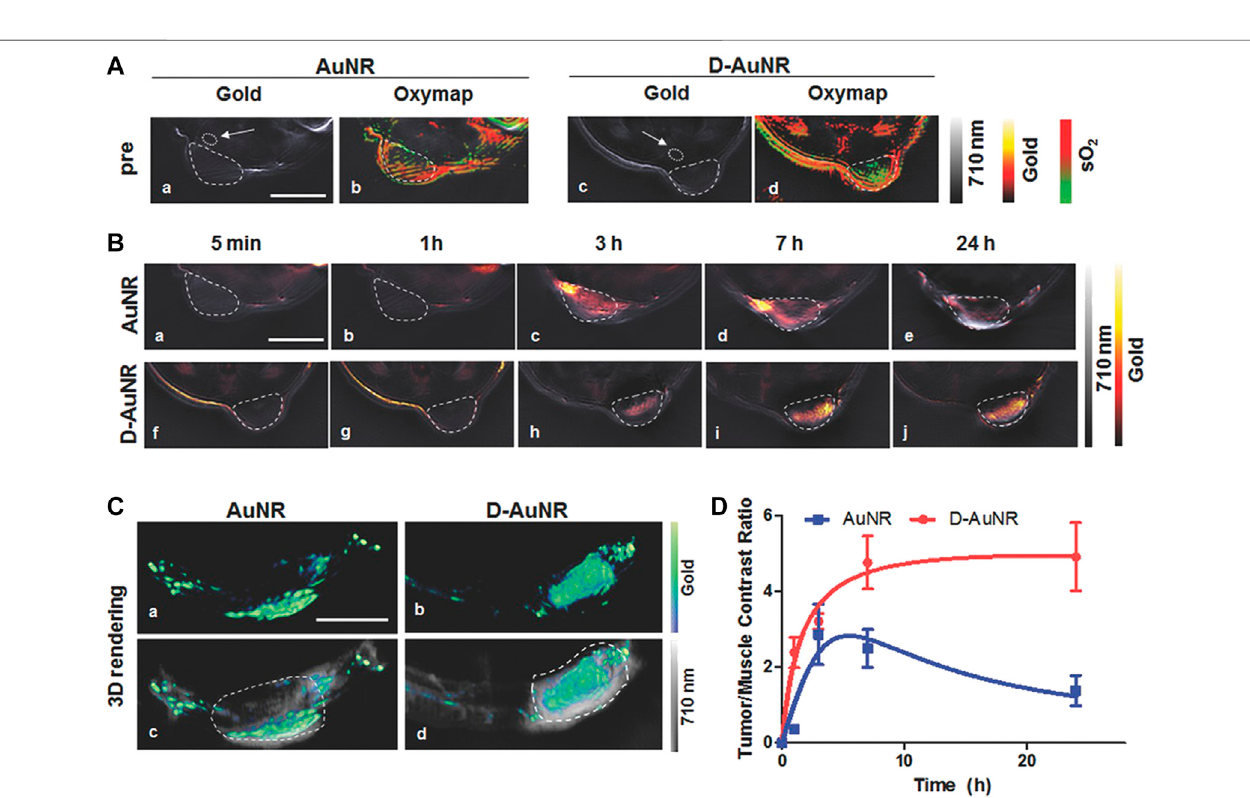
FIGURE 5 | Optoacoustic evaluation of DNA-Nanostructure-Gold-Nanorod Hybrids which achieve better accumulation in tumor sites than pure GNRs. (A) The gold distribution (hot scale, a,c) and the corresponding oxygen-saturation maps (green to red scale, b,d) before intravenous injection of GNRs and GNRs with DNA nanostructures (D-GNRs) in 4T1-tumor-bearing mice. (B) GNRs and D-GNRs distribution (hot scale) at several time points including 5 min (a,f), 1 h (b,g), 3 h (c,h), 7 h (d,i), 24 h (e,j) after intravenous injection in 4T1-tumor-bearing mice (dashed outlined) overlayed on an optoacoustic image acquired at a single illumination wavelength (710 nm, gray scale). Scale bar (cid:1) 5 mm. (C) 3D rendering the optoacoustic images in the cancerous regions on 4T1-tumor-bearing mice 24 h postinjection oftheGNRs(a,hotscale)andD-GNRs(b,hotscale),overlayedonsinglewavelengthimages(c,d,710 nm,grayscale).Scalebar (cid:1) 5 mm. (D) Contrastratiobetweenthe tumor and the region of back muscles extracted from the images for GNRs (blue) and D-GNRs (red). A section of the back muscle (indicated by the white arrows) is outlined in the initial single wavelength image (Du et al., 2016b).